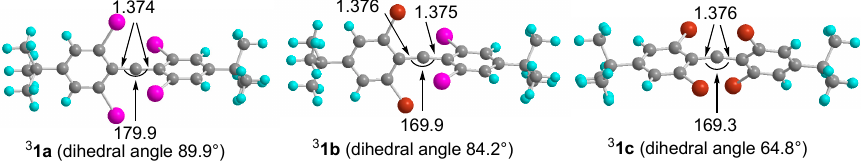
Figure 4. Calculated (M05/3–21G for I atom and 6–31G* for other atoms) structures and selected bond distances (in Å) and angles (in degrees) of triplet carbenes 3 1a , 3 1b , and 3 1c .